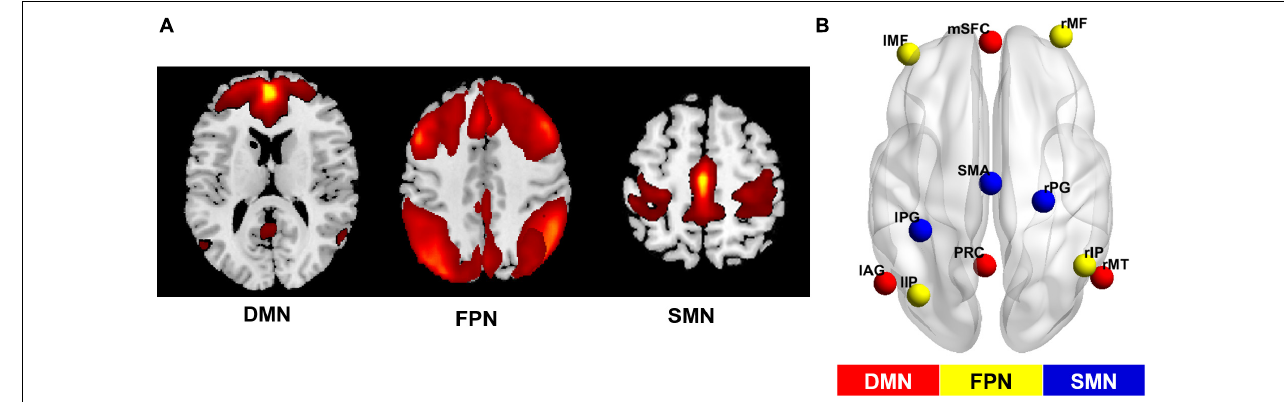
FIGURE 3 | Networks of interest and their simplified sub-regions identified by GICA. (A) The spatial maps of the default mode network (DMN), the fronto-parietal network (FPN) and the somatomotor network (SMN) identified by group independent component analysis (GICA). The first two maps were thresholded with T = 1, while the third was thresholded with T = 3. Specifically, the FPN was synthesized from the left and right FPN components. (B) Locations of brain areas adopted from GICA results. The former networks were simplified as several main sub-regions, and the coordinates of peak values in the GICA map were chosen as center coordinates of the regions at the group level. This information was used to construct the dynamic causal model for each network. mSFC, medial superior frontal cortex; PRC, precuneus; lAG, left angular gyrus; rMT, right middle temporal gyrus; l/rMF, left/right middle frontal gyrus; l/rIP, left/right inferior parietal gyrus; SMA, supplementary motor area; l/rPG, left/right postcentral